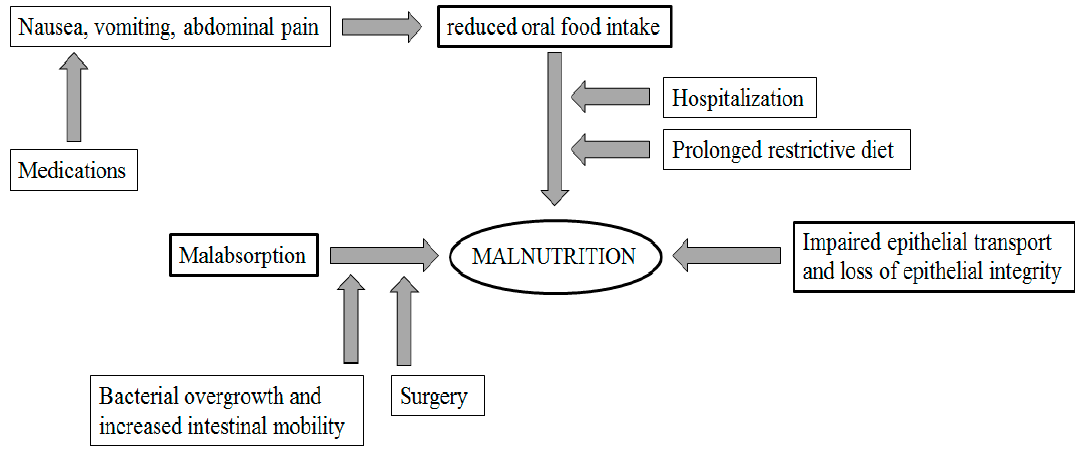
Figure 1. Mechanisms of malnutrition in inflammatory bowel disease (IBD) patients.